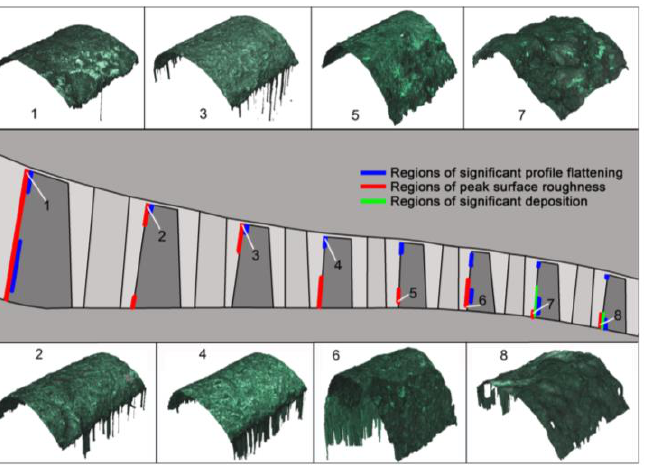
Figure 6. The spatial arrangement of three degradation forms of leading edge for IPC blades. Adapted with permission from [8], Copyright Elsevier, 2014.